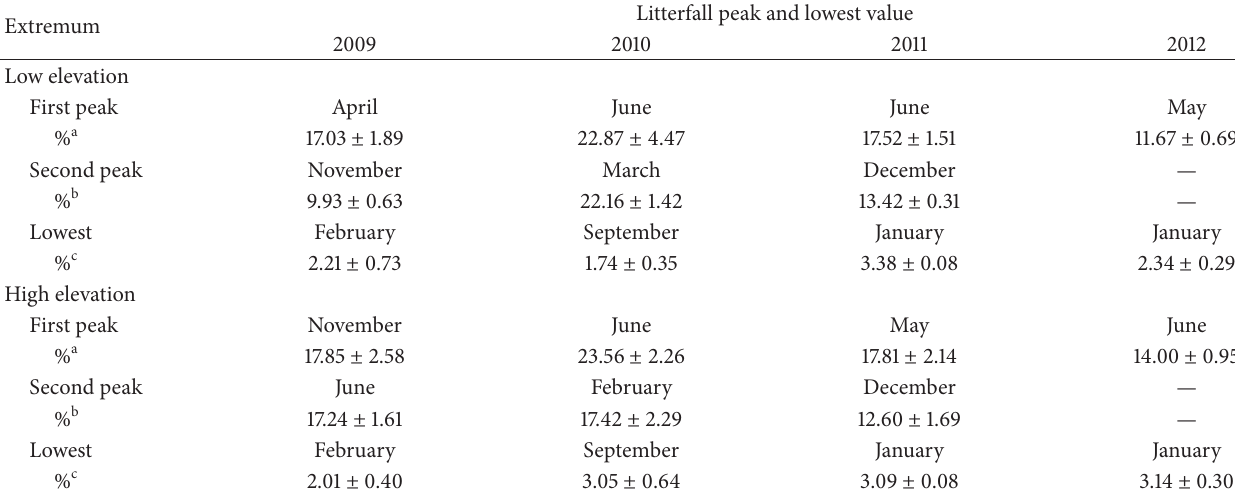
Table 2: The occurring time of litterfall peak and valley value and the percent of extremum value to total litterfall at two elevations.